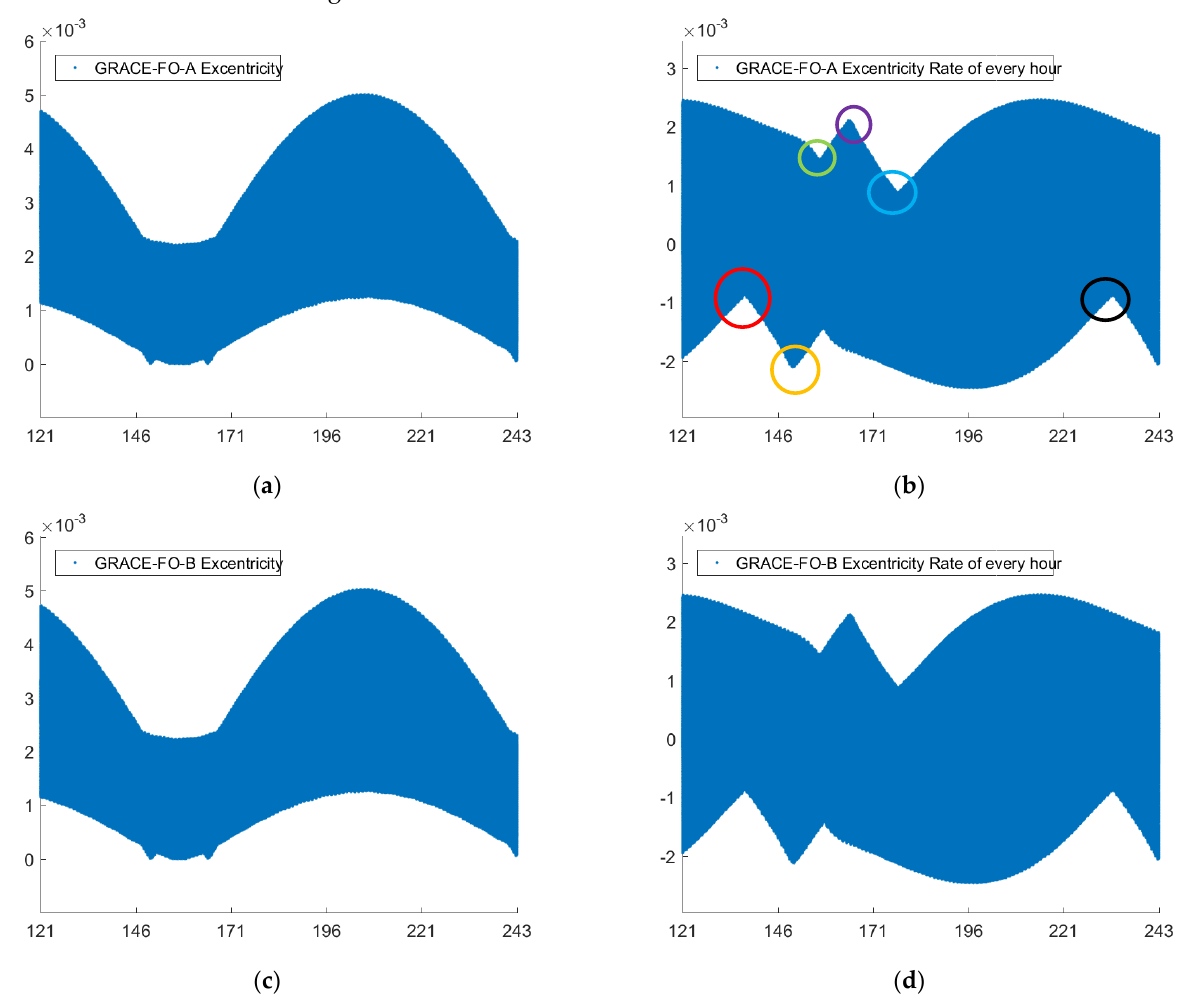
Figure 13. Eccentricity and eccentricity variation of GRACE-FO satellites (hourly variation). Table 9. Days of Orbital Maneuver.